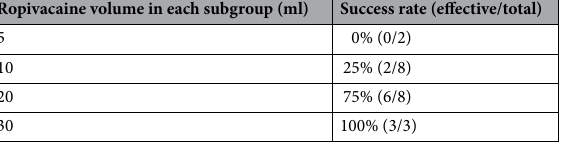
Ropivacaine volume in each subgroup